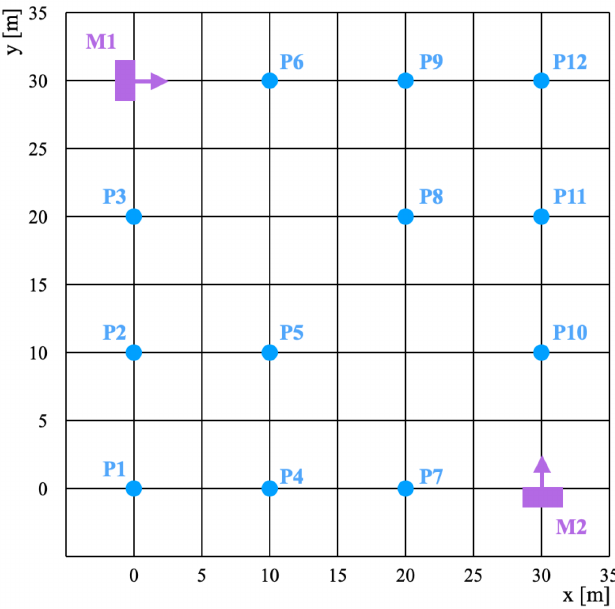
Figure 11. Setup of sound source positions and microphone arrays for Experiment